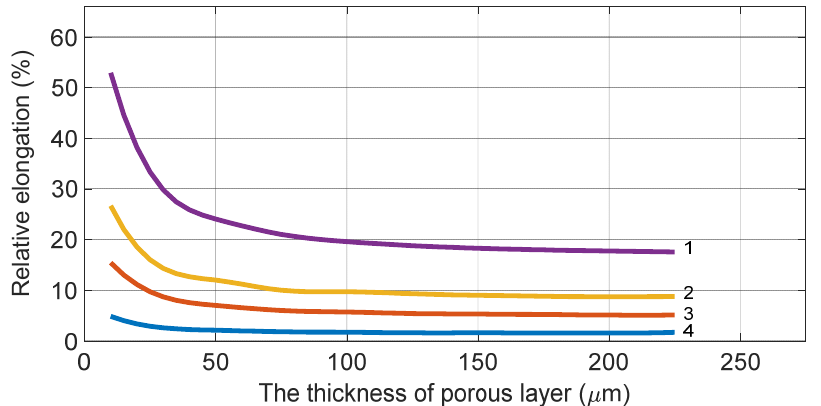
Figure 5. The relative elongation ( ε ) versus the thickness of the porous layer ( h ) at various pressures in the high-pressure channel: 1—10 MPa, 2—5 MPa, 3—3 MPa, and 4—1 MPa. The selective layer is located on the inner surface of the fiber.